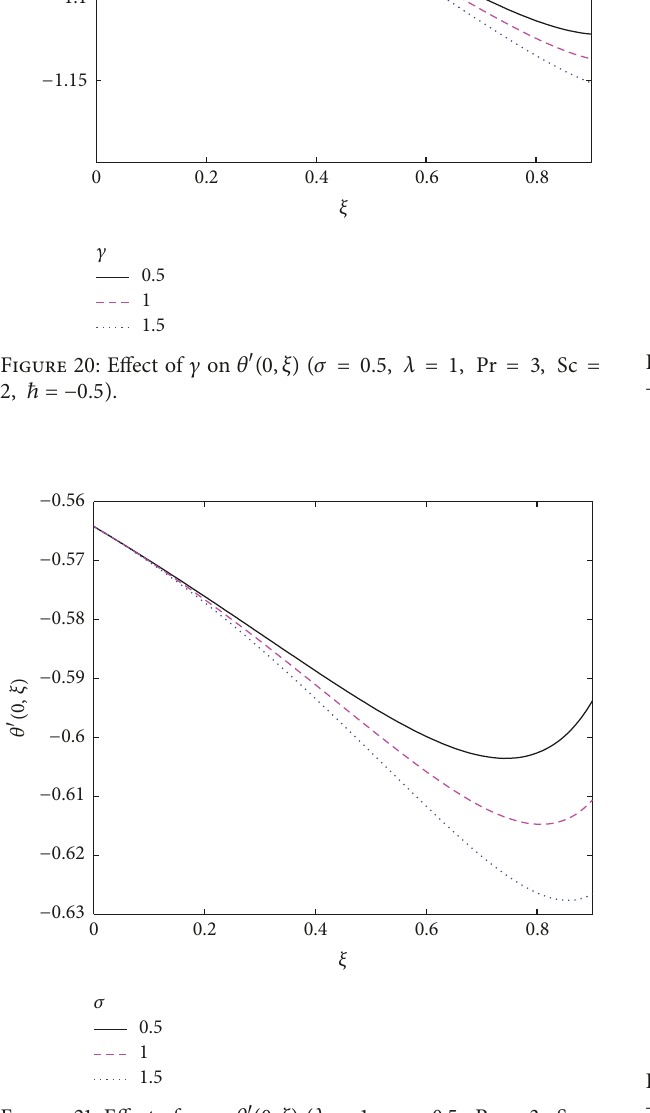
Figure 21: Effect of 𝜎 on 𝜃 󸀠 (0, 𝜉) ( 𝜆 = 1, 𝛾 = 0.5, Pr = 3, Sc = 2, ℏ = −0.5 ).